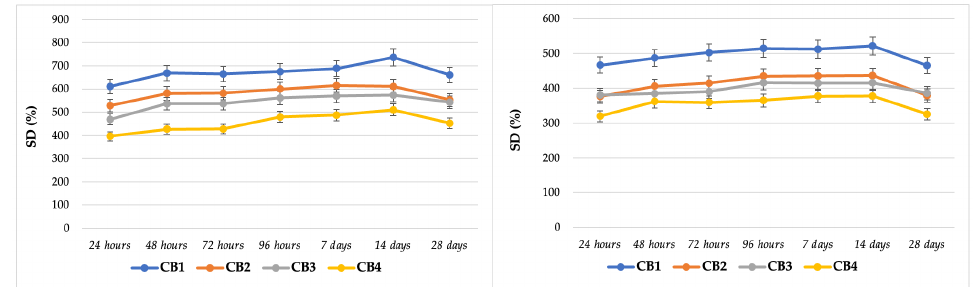
Figure 8. Swelling in physiological serum ( left ) and SBF ( right ) .